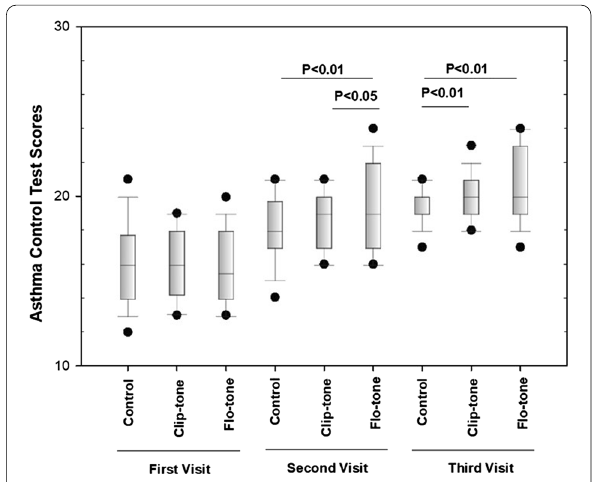
Fig. 5 Comparing medians of asthma control test scores of different Interventions per visit